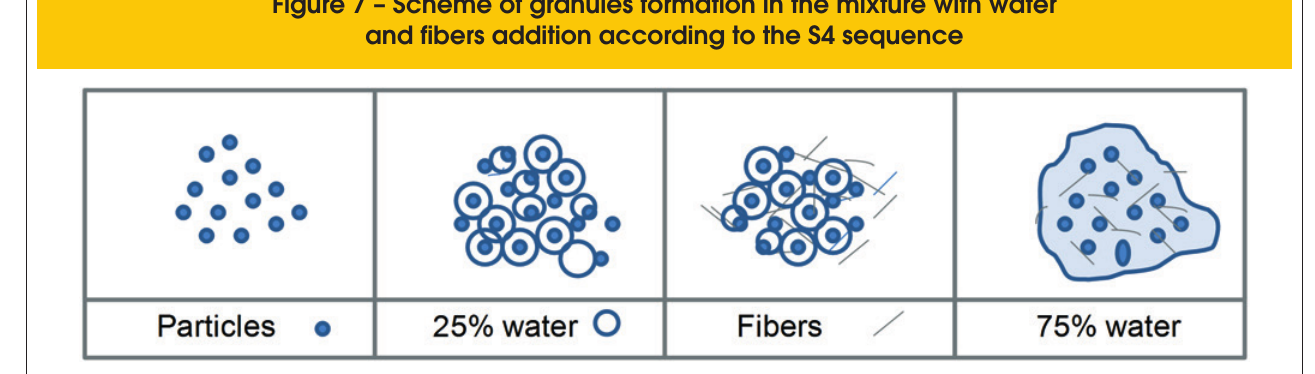
Figure 7 – Scheme of granules formation in the mixture with water and fibers addition according to the S4 sequence